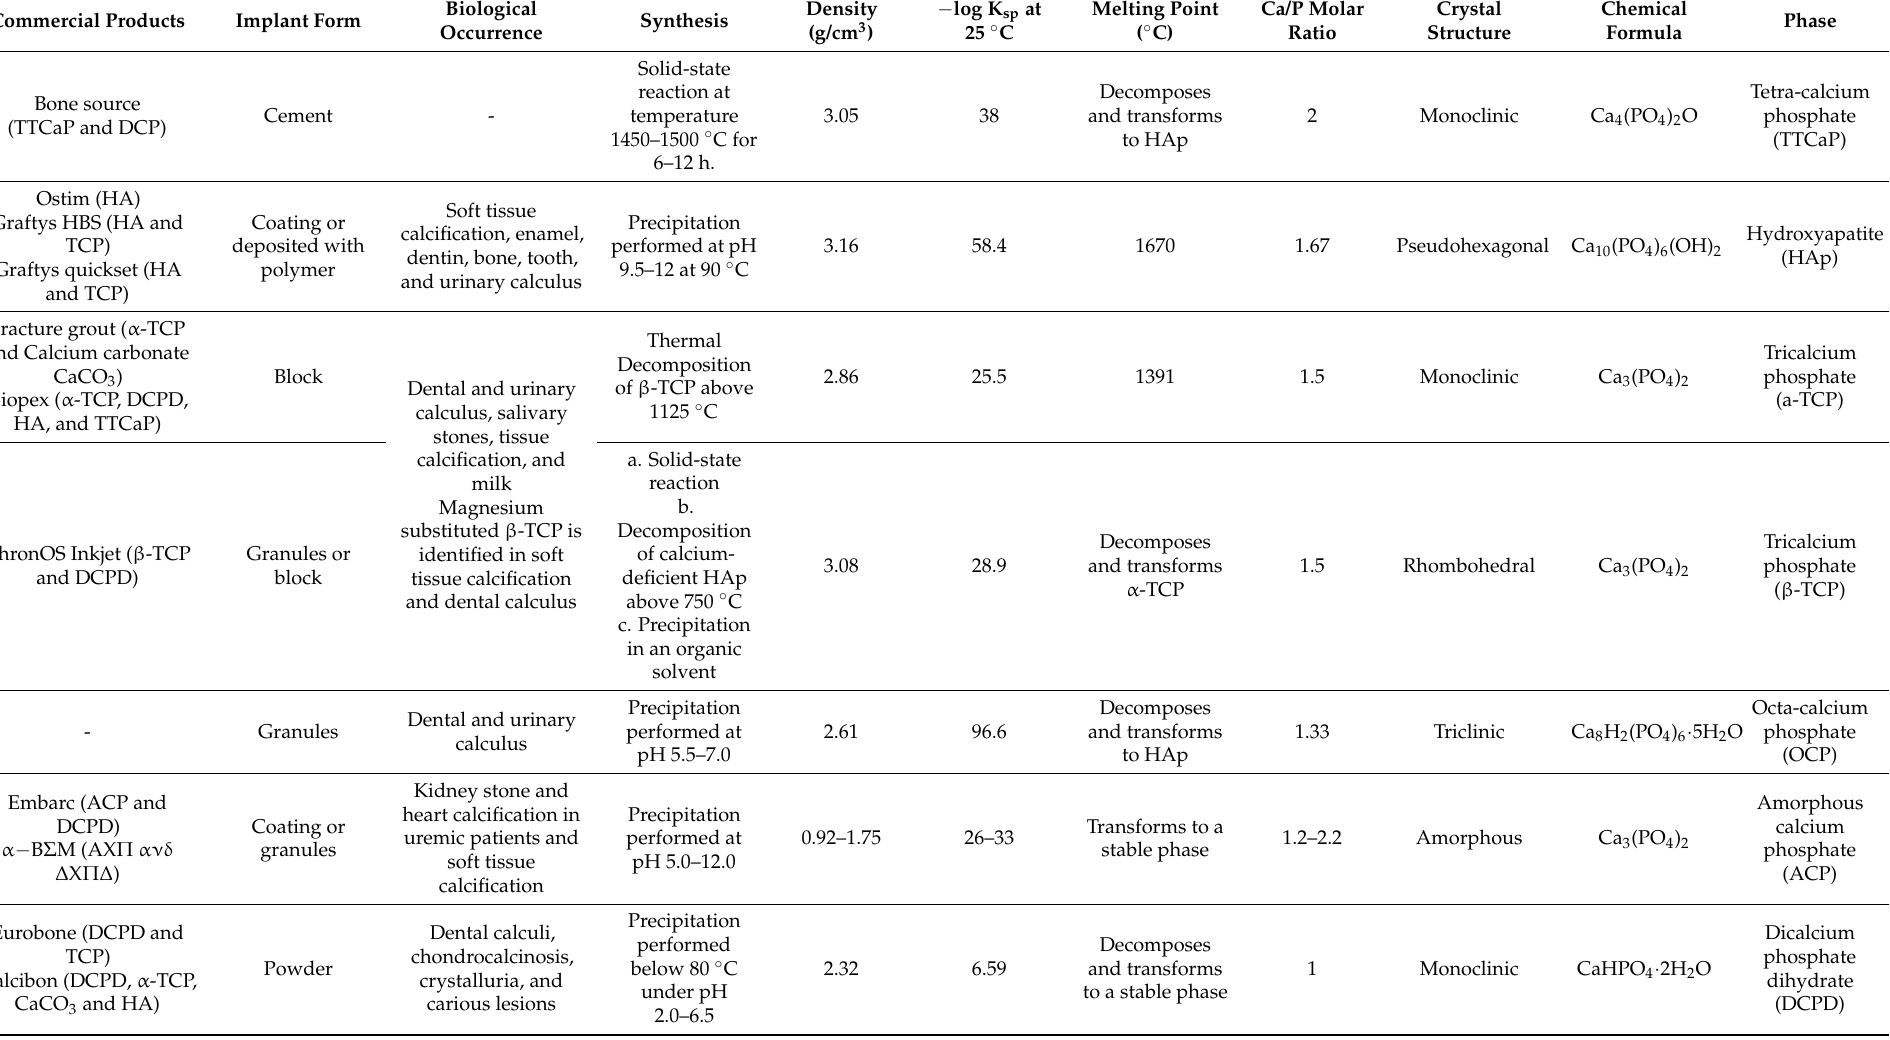
Table 1. Physical properties, synthesis, and application of various types of calcium phosphates. Adapt from references